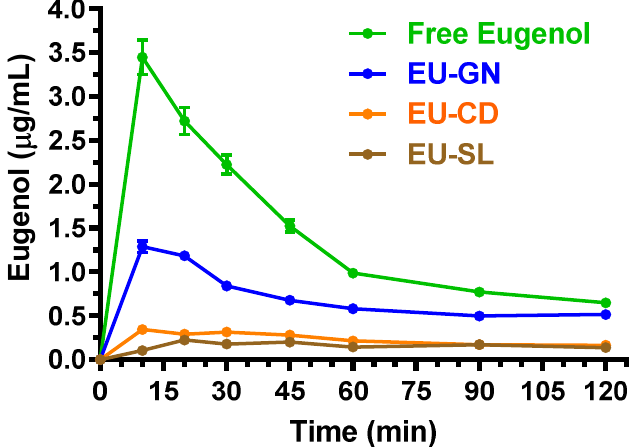
Figure 6. Blood eugenol concentrations ( µ g/mL) within 120 min after oral administration of 500 mg/kg doses to rats. Data are expressed as the mean ± SE of four independent experiments. The oral formulations consisted of dissolved eugenol in corn oil (free eugenol), or eugenol adsorbed on vegetal fibers (EU-GN) or complexed with cyclodextrins (EU-CD) or included with soy lecithin (EU- SL).